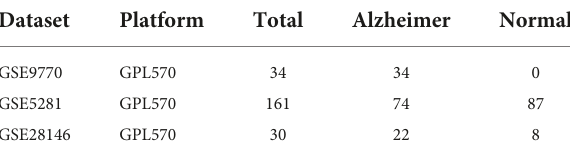
TABLE 1 Alzheimer’s disease (AD)-related microarrays datasets in hippocampus.